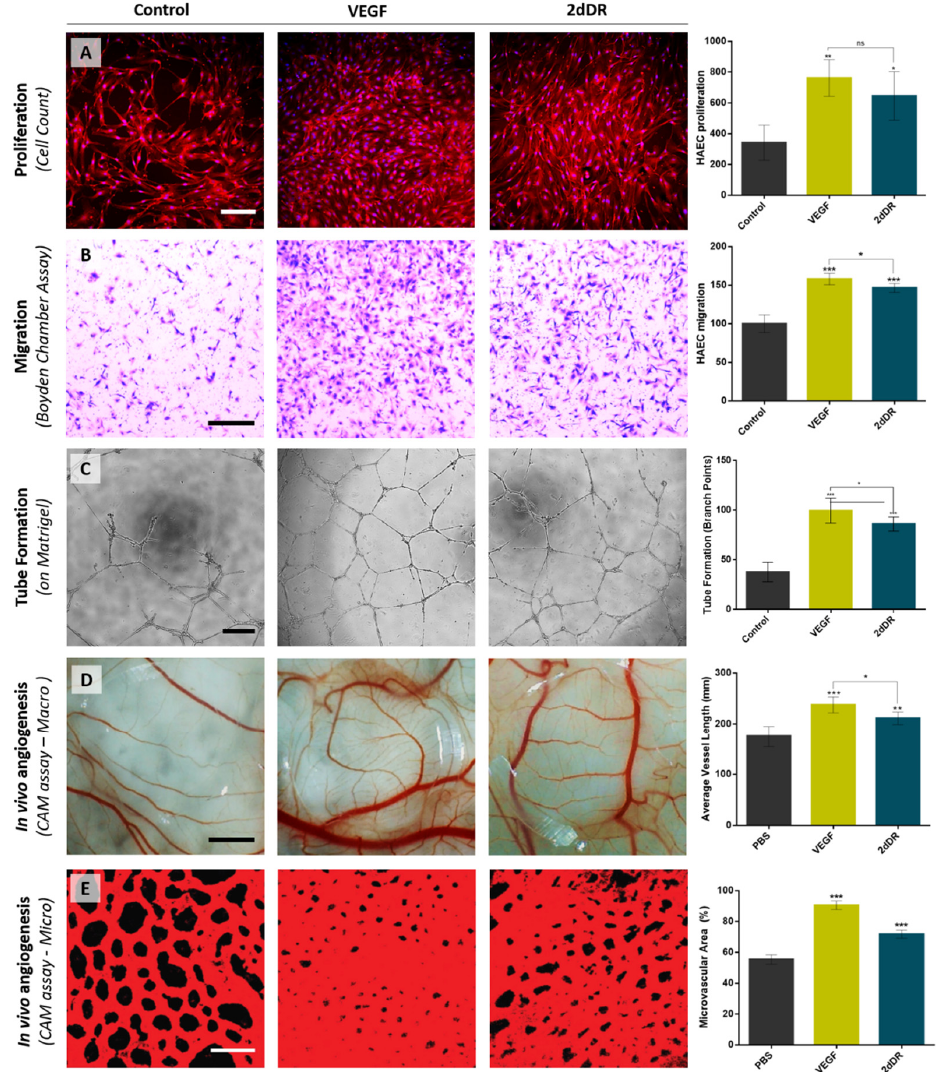
Figure 5. Representative images demonstrating the pro-angiogenic potential of 2dDR compared to VEGF in terms of stimulating the ( A ) proliferation, ( B ) migration, ( C ) tube formation of HAECs, and in vivo angiogenesis assessed by ( D ) macro vessels and ( E ) mi- crovasculature in ex ovo CAM bioassay. (*** p ≤ 0.001, ** p ≤ 0.01, * p ≤ 0.05, ns: not signif- icant, n = 3). Scale bars represent 200 µm for proliferation, 250 µm for migration and